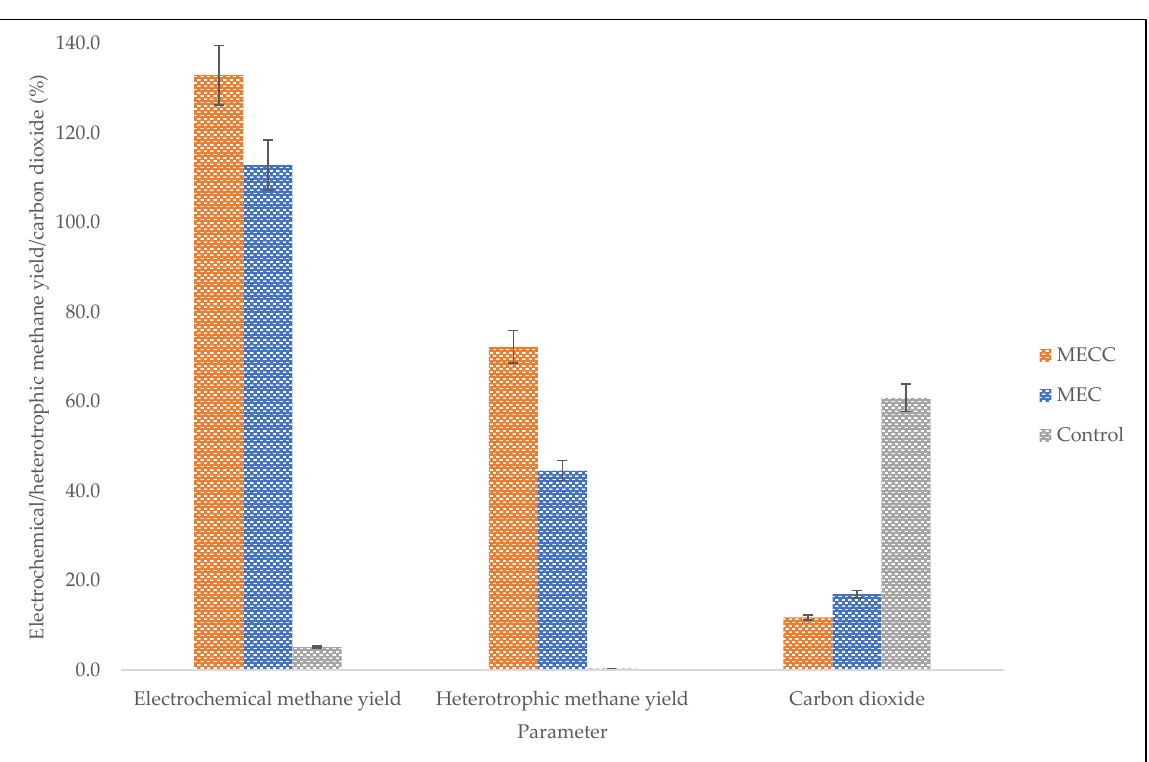
Figure 3. Effect of current density on digester type.